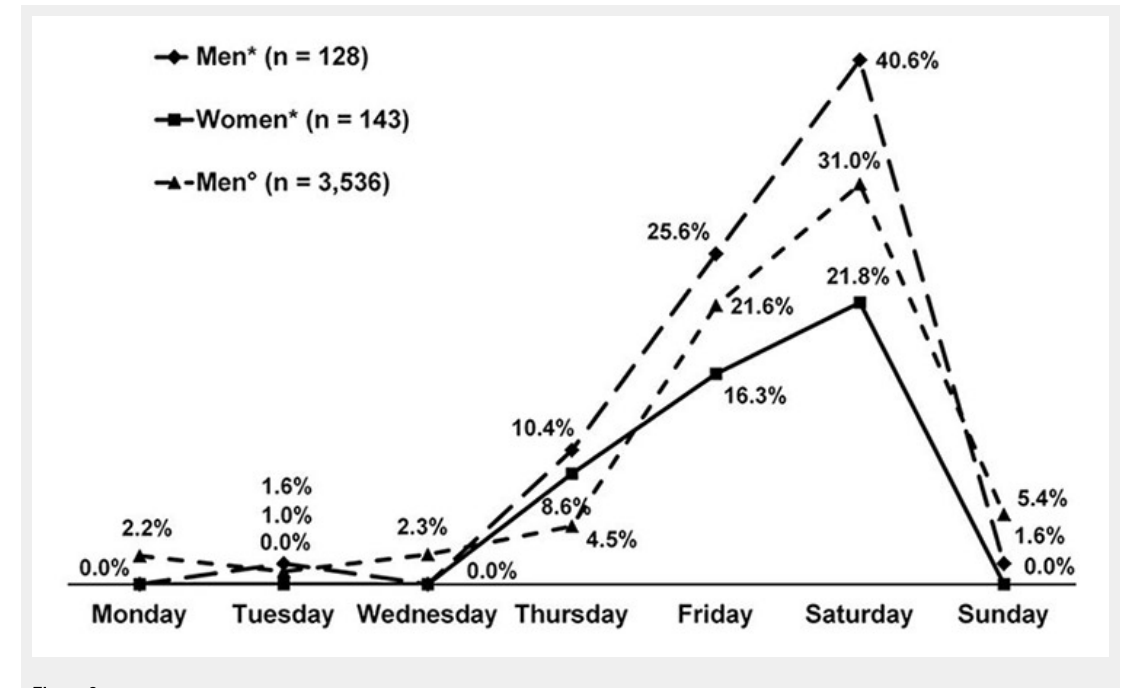
Figure 2 Percentage of individuals regularly consuming more than four drinks on a single occasion in the last 30 days by gender and day of the week. Note: *mean age = 23.1 years, standard deviation = 3.1 years, data taken from Kuntsche and Labhart [23]; °19-year-olds, data taken from Gmel et al.